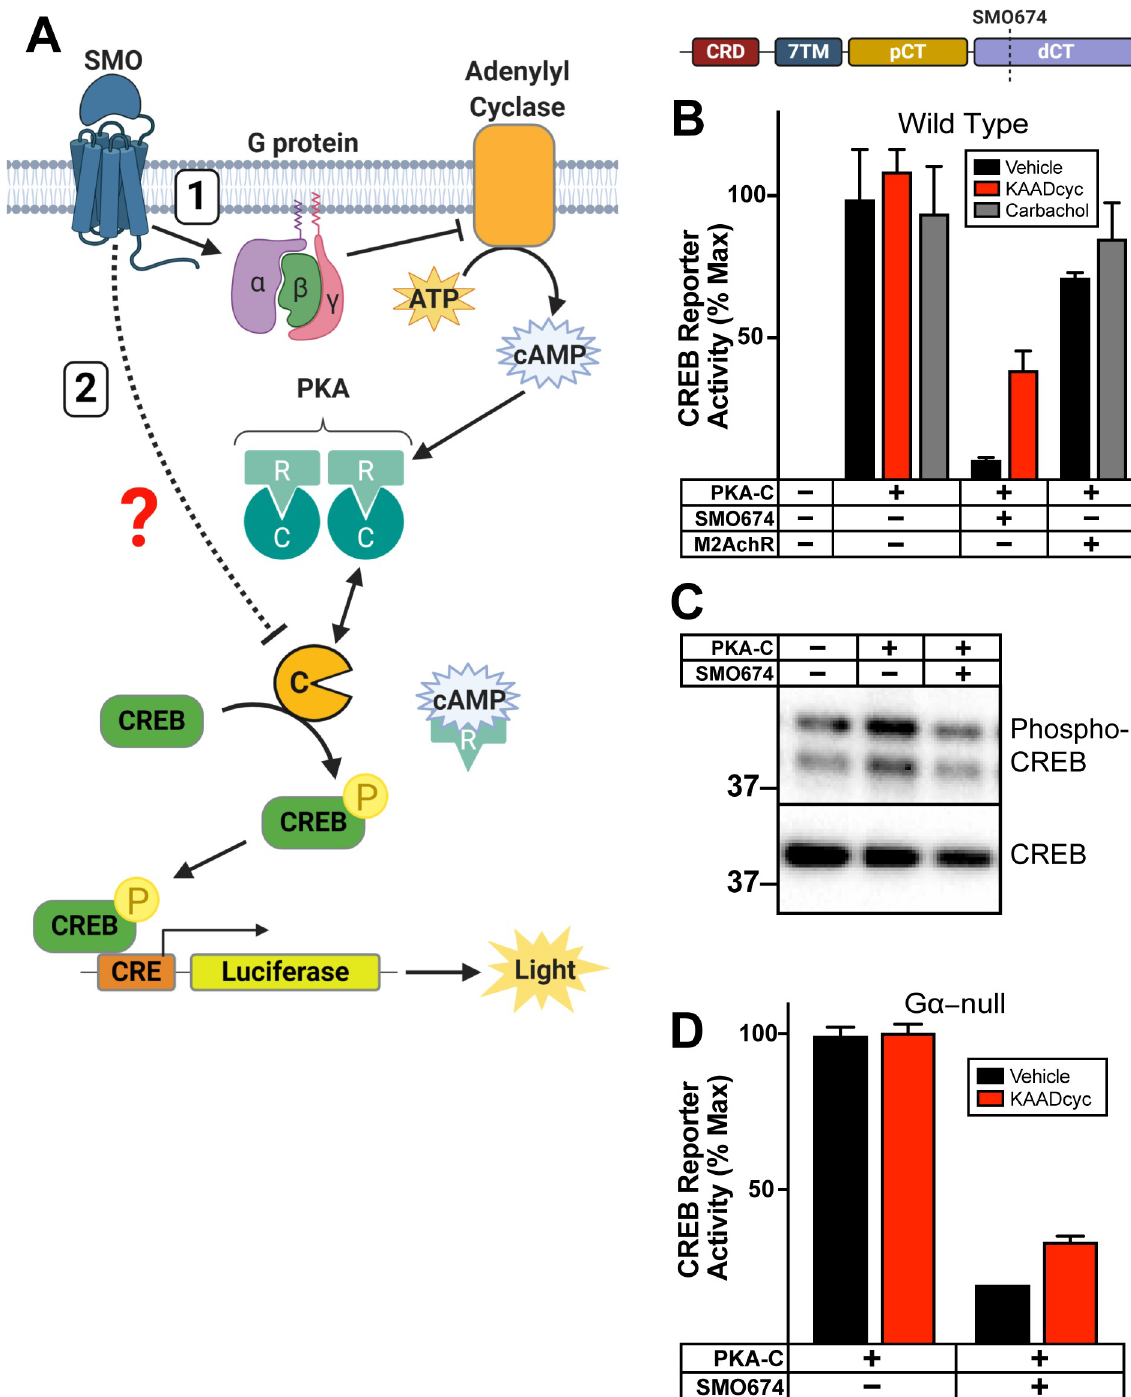
Fig 1. SMO inhibits PKA substrate phosphorylation in a G protein–independent manner. ( A ) Schematic of assay to report PKA activity toward soluble substrates. PKA-C phosphorylates CREB which binds CRE, inducing expression of luciferase. SMO can inhibit PKA-C by decreasing cAMP via inhibitory G proteins and AC (route “1”). Alternatively, SMO may inhibit PKA-C via a G protein–independent mechanism (route “2”). ( B ) Wild-type HEK293 cells were transfected with CRE-luciferase reporter plasmid and GFP (as a negative control) or PKA-C, either alone, with SMO674 (see cartoon above), or with a canonical G α i/o -coupled GPCR, M2AchR. Transfected cells were treated with the indicated drugs (vehicle control, M2AchR ligand carbachol (3 μ M), or SMO inverse agonist KAADcyc (1 μ M)). Following drug treatment, cells were lysed and luminescence measured. Note that transfected SMO is constitutively active in HEK293 cells because its inhibitor